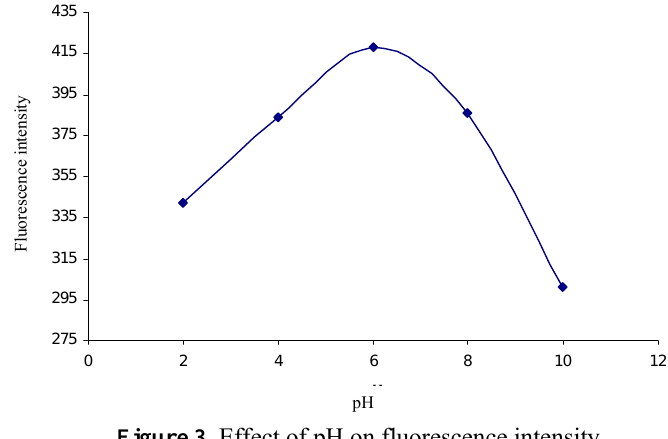
Figure 3. Effect of pH on fluorescence